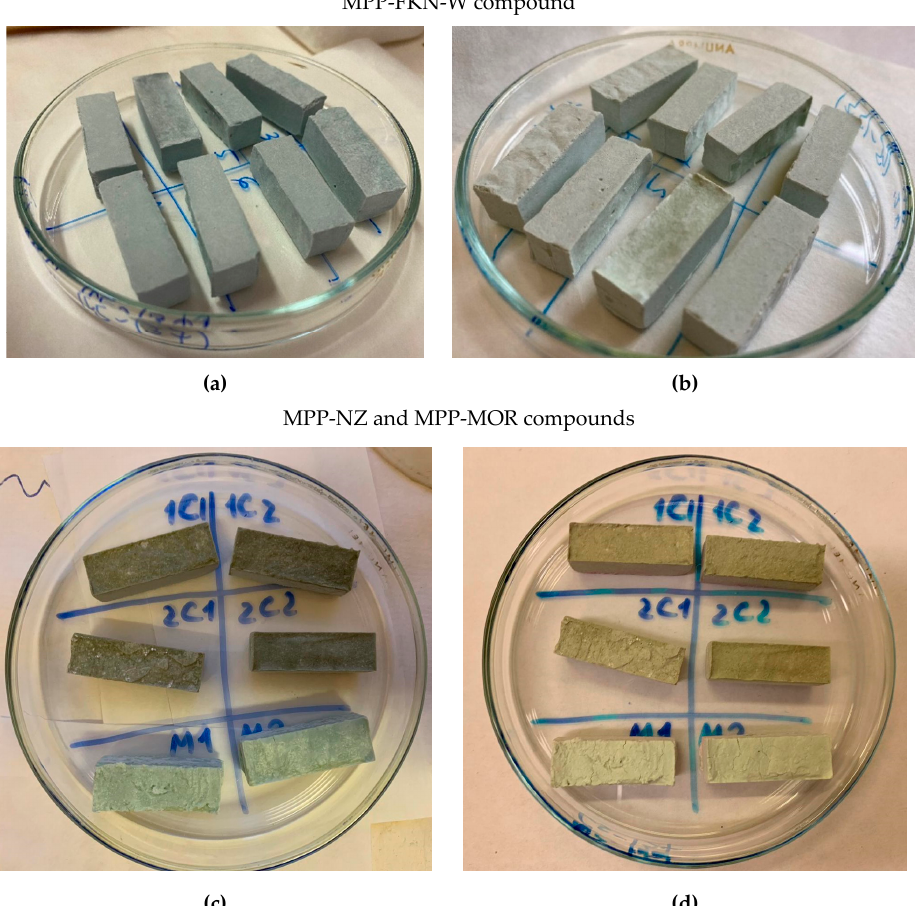
Figure 1. Photos of initial MPP compounds ( а , c ) and their photos after heat treatment ( b , d